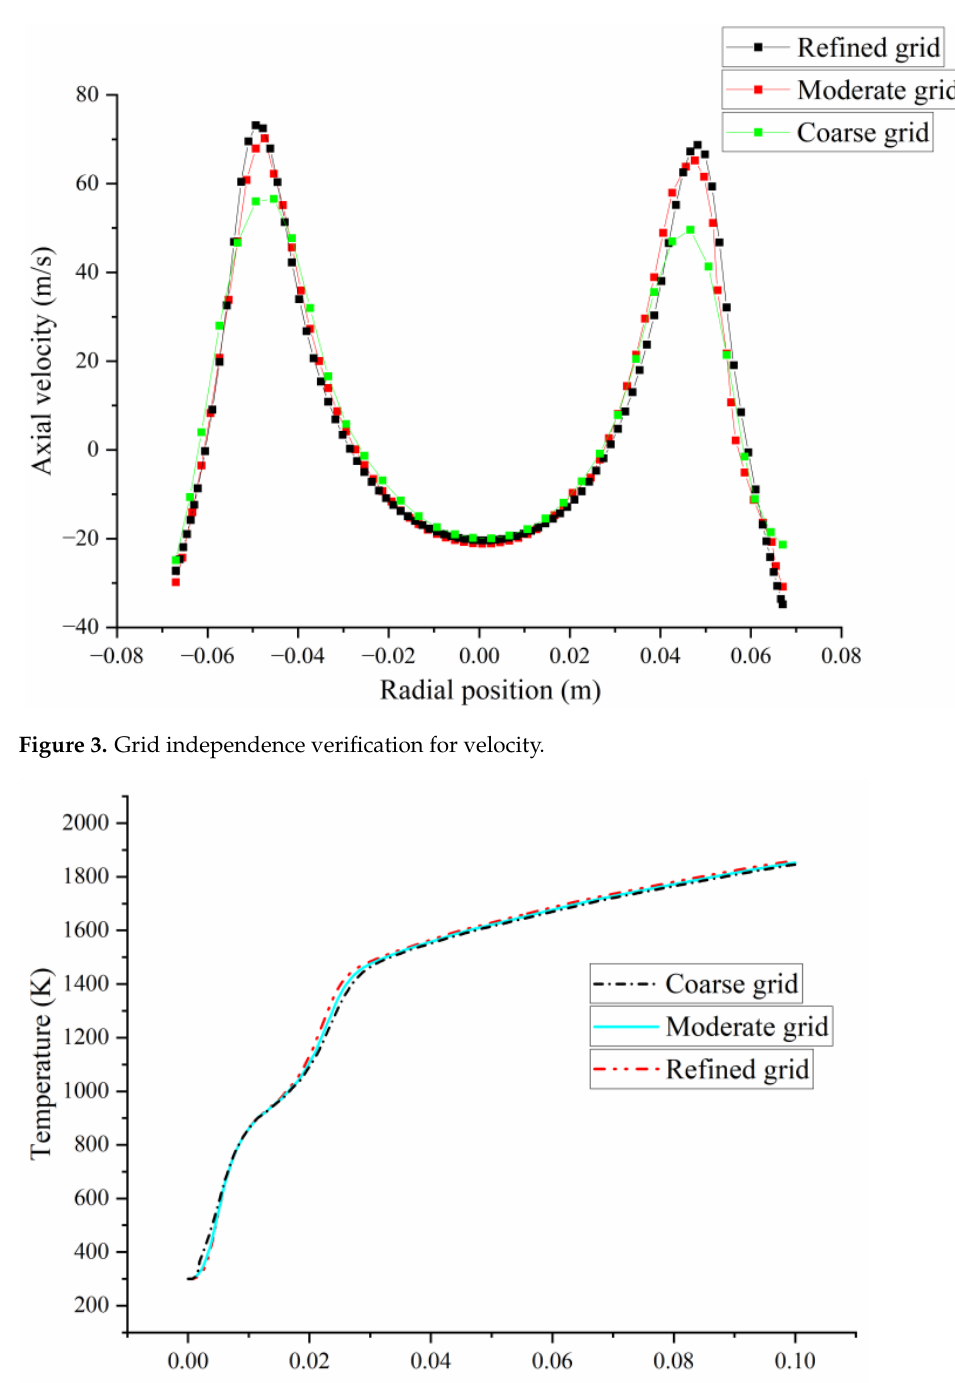
Figure 3. To validate the mesh independency of the flame structure. The smaller geometries in Ren’s work [36] are used to verify the grid convergence of the flame structure with three different densities of grid (2 M, 6 M and 16 M). The temperature distributions on the central axis are shown in Figure 4. It can be seen that the mesh size has little effect on the flame structure. Hence, the numerical results were supposed to be independent of mesh densities in this paper.